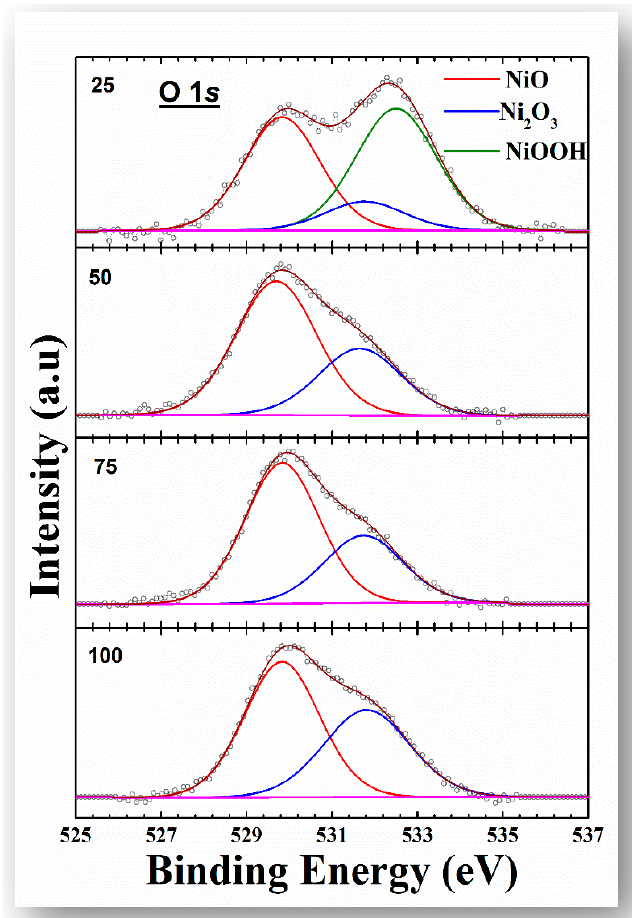
Figure 6. O1 s core level spectra.